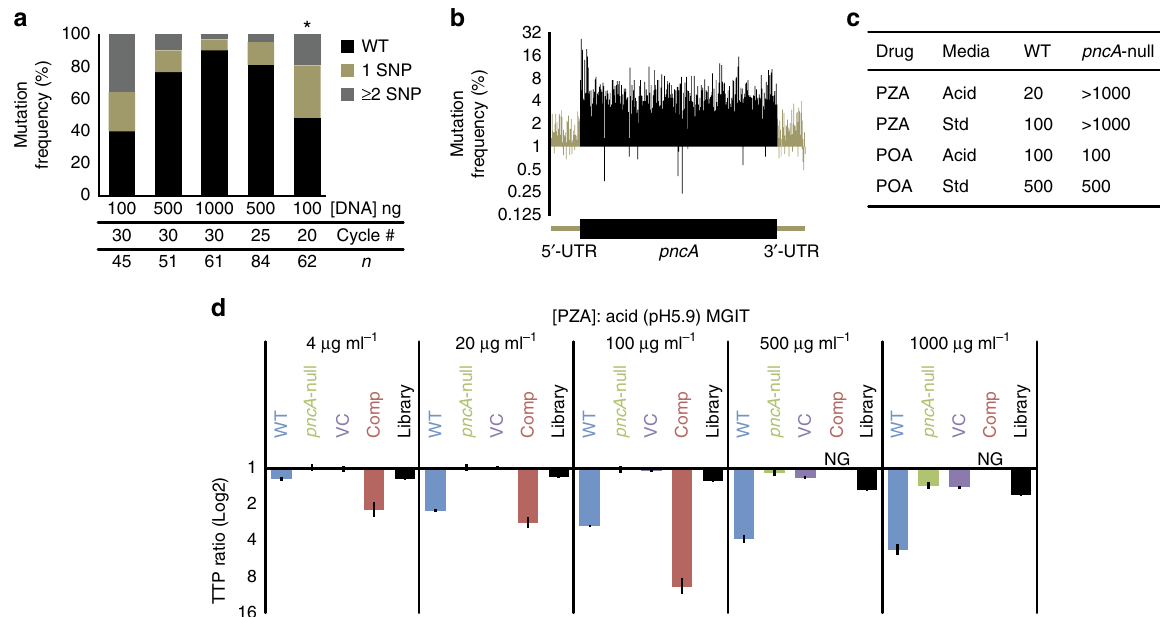
Fig. 1 Generation of a comprehensive pncA mutant library in M. tuberculosis . a Frequency (%) of pncA single-nucleotide polymorphisms in fi ve pncA libraries generated by random PCR mutagenesis using different template concentrations (DNA ng) and cycle numbers (#). n corresponds to the number of single colonies sequenced from each library and * the library selected for screening. b The mean pncA SNP frequency (%) from three biological replicates at each nucleotide of our candidate library relative to the mean of three biological replicates of an unmutagenized wild-type control determined using Illumina sequencing. c Minimum inhibitory concentration ( MIC , μ g ml -1 ) of pyrazinamide (PZA) and pyrazinoic acid (POA) for three isogenic control strains, WT, pncA -null, and Comp, in pH 5.9 (Acid) and pH 6.8 (Std) media. d Growth inhibition of four isogenic control strains, WT, pncA -null, Comp and a vector control ( VC ), and the pncA library with increasing concentrations of pyrazinamide in pH 5.9 (acid) media. Time-to-positivity ( TTP ) ratio is the mean of the time-to-positivity of the test condition relative to the mean of the no-drug control. A minimum of three biological replicates per strain per test condition was performed. Error bars represent the standard deviations derived from the propagation of error using the quotient of the coef fi cient of variation from each condition. NG no